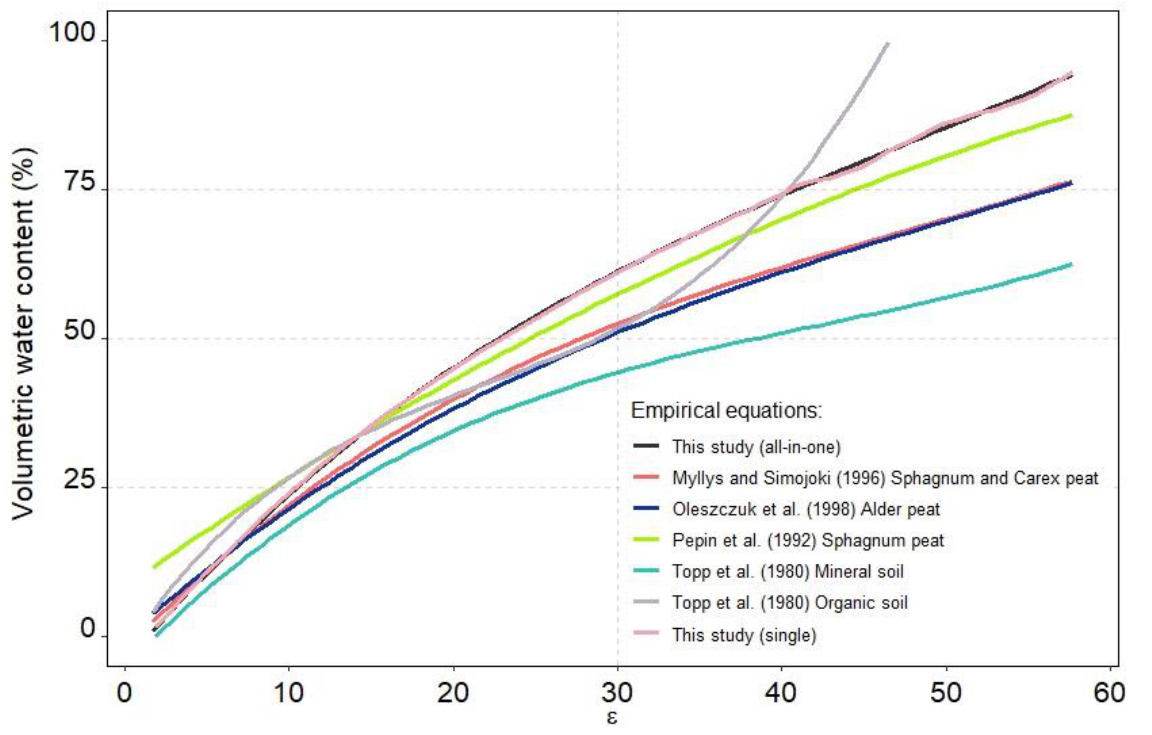
Figure 3. Comparison of previously published third-order polynomial equations for calibration of TDR measured volumetric water content (%), of organic soils. All equations (and their constants) were applied to the dataset derived in this study, with this study’s calibrations as reference. Faded red dashed lines indicate θ of 25, 50, and 75 %. ε is the dielectric permittivity. The faded blue dashed line indicates ε = 3 0 [11,15,35,36].